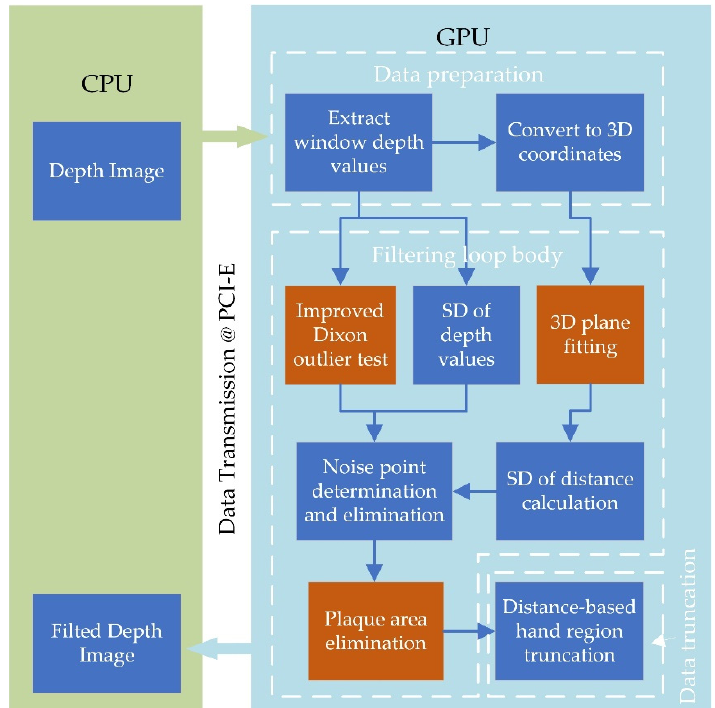
Figure 3. Proposed filtering system for hand depth image. The part with GPU algorithms of the system can be divided into three sub-parts. (1) Data preparation: extract the depth data of all points in the window corresponding to each thread, and work out their 3D coordinates. (2) Filtering loop body: as the core part of the filtering system, its main function is to identify the noise points and filter them out. (3) Data truncation: preserving the foreground and eliminating the depth image of the background. In addition, the three filtering algorithms proposed for different types of noise areas are marked in red boxes.